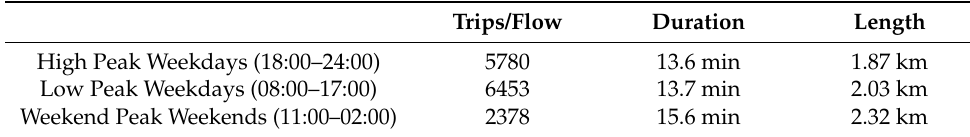
Table 2. Average flow characteristics for each scenario.